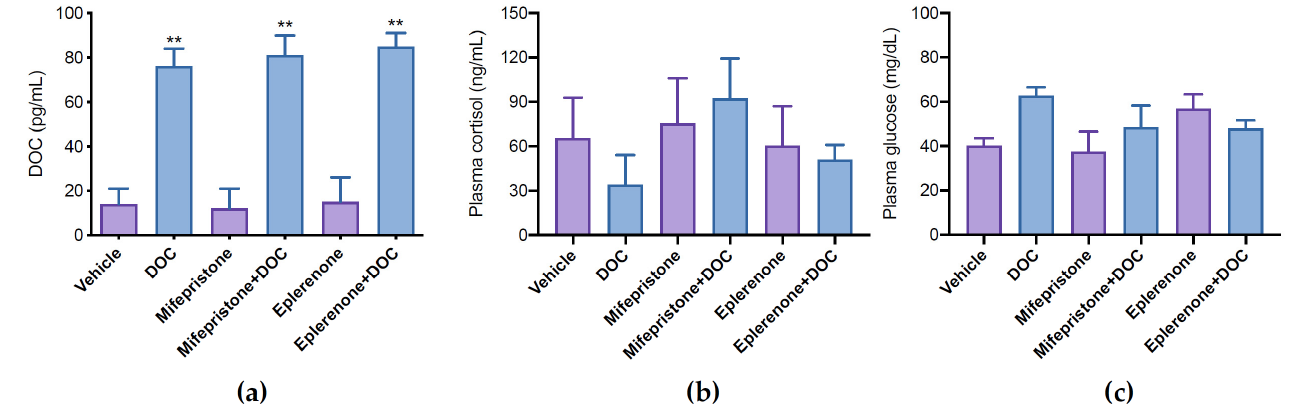
Figure 1. DOC, cortisol, and glucose quantification in plasma. DOC ( a ), cortisol ( b ), and glucose ( c ) in plasma were quantified in juvenile fish treated with vehicle, 11-deoxycorticosterone (DOC), mifepristone, eplerenone, mifepristone plus DOC, and eplerenone plus DOC. The results are expressed as means ± SEM (n = 4 per treatment). The ** symbol ( p < 0.01) represents significant differences.